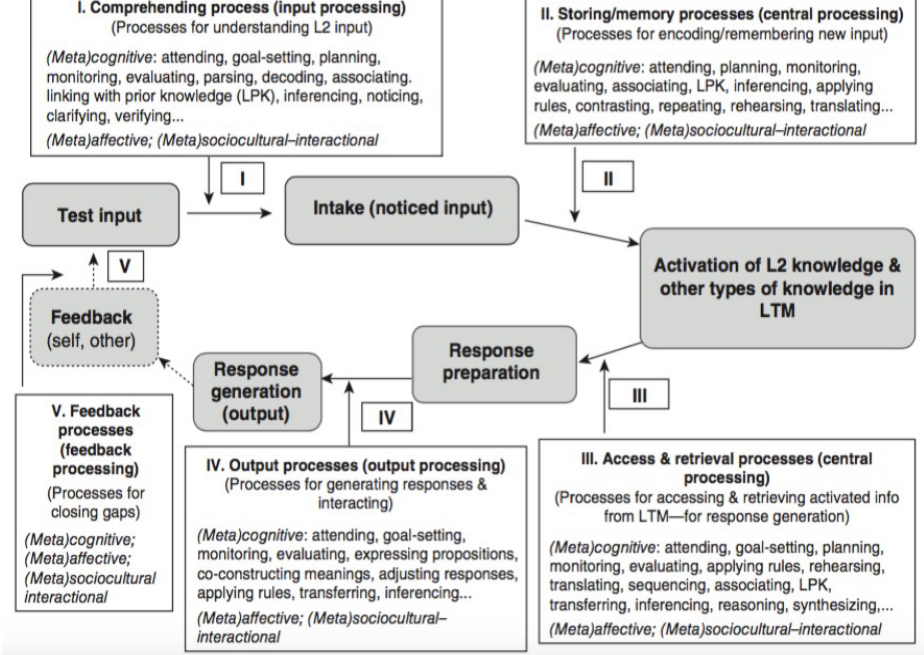
The interface of cognitive competence and L2 processing in assessment. Adapted from Purpura